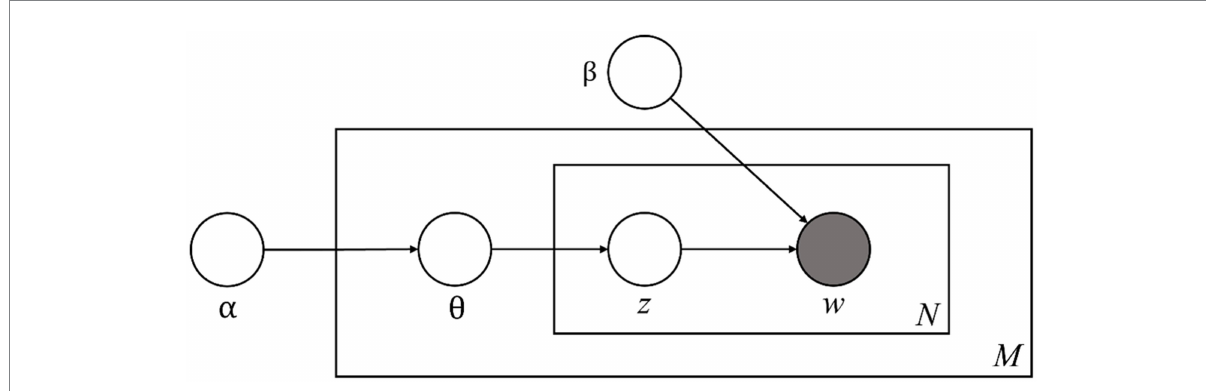
FIGURE 1 Probabilistic graphical model of latent Dirichlet allocation α : a parameter that represents the Dirichlet prior for the document topic distribution, β : a parameter that represents the Dirichlet for the word distribution, θ : a vector for topic distribution over a document d, z : a topic for a chosen word in a document, w : specific words in N , M : the length of documents, N : the number of words in the